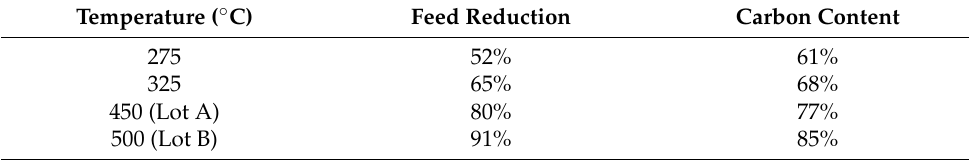
Table 1. Thermal treatment conditions and